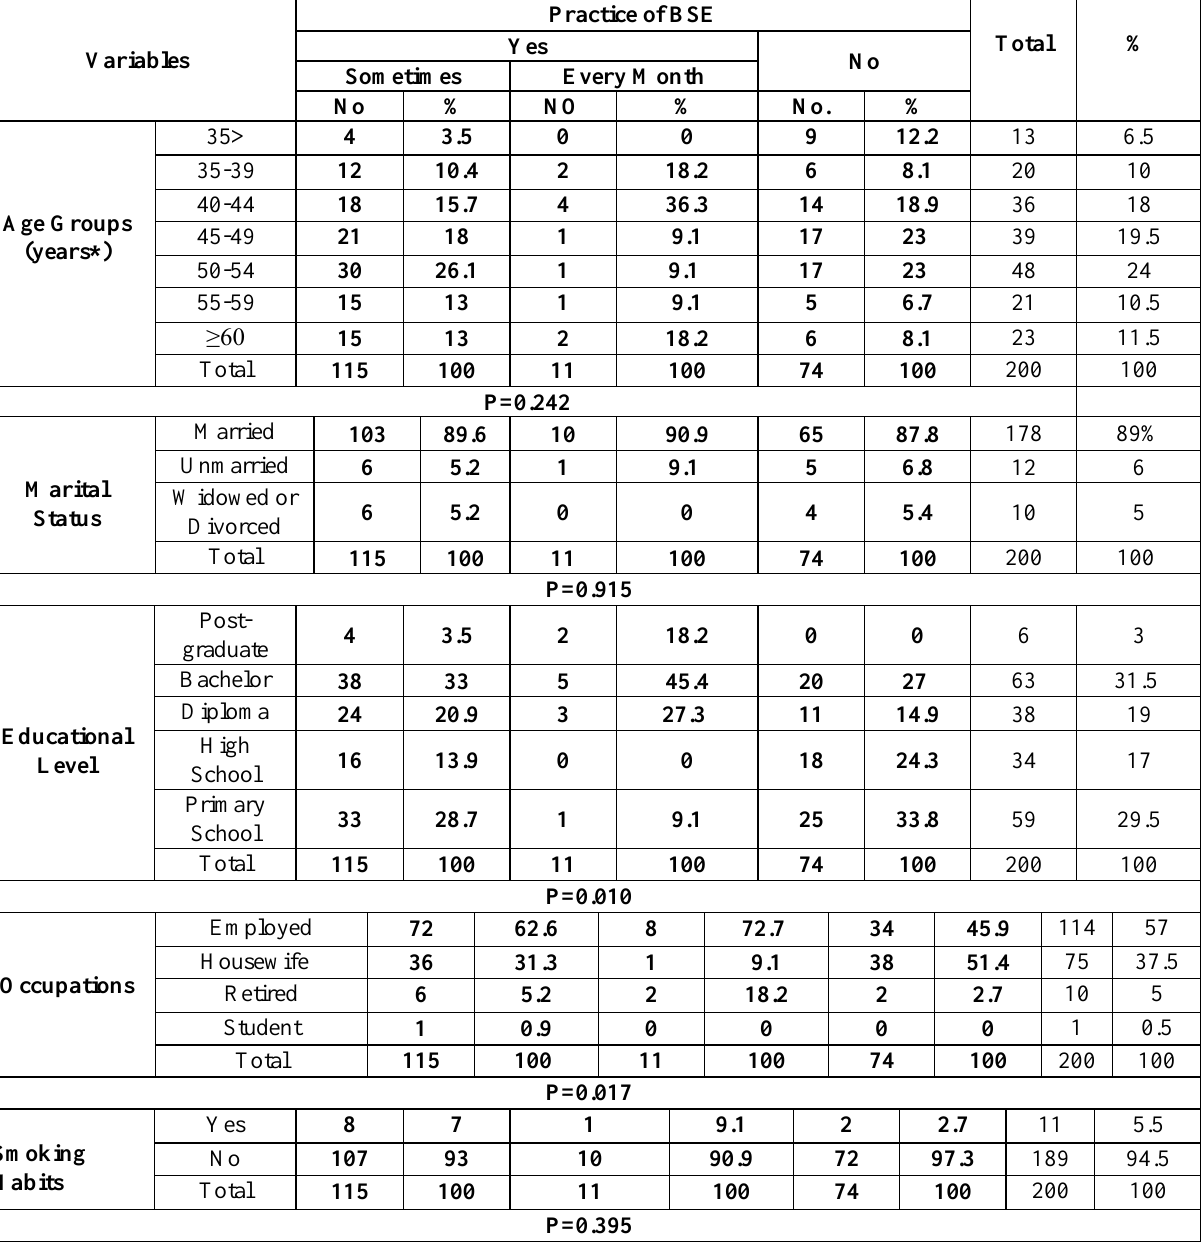
Table (1): Correlation of patients' age, marital status, education, occupation and smoking habit with the practice of BSE among female breast cancer female